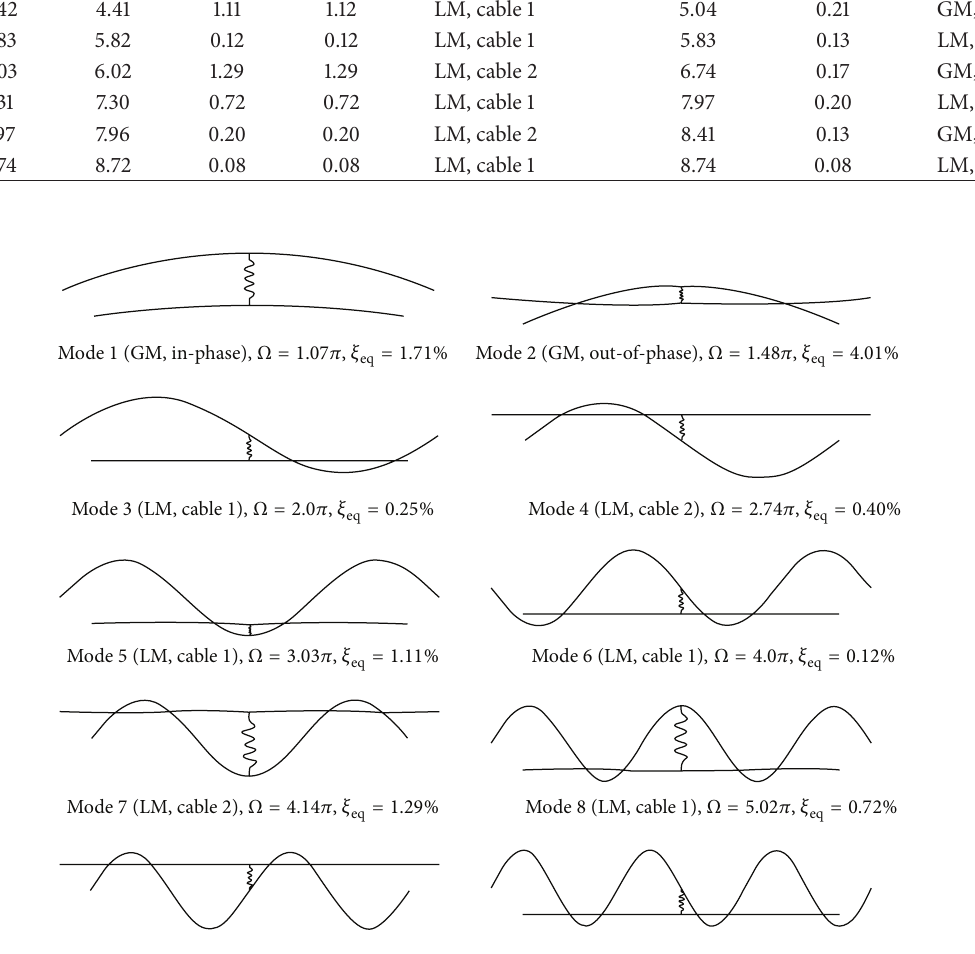
Figure 4: First ten modes of a symmetric DMT two-cable network with a damped flexible cross-tie ( 𝐾 𝑐 = 30.54 kN/m, 𝐶 𝑐 = 1.0 kN ⋅ s/m) at 𝜀 = 1/2